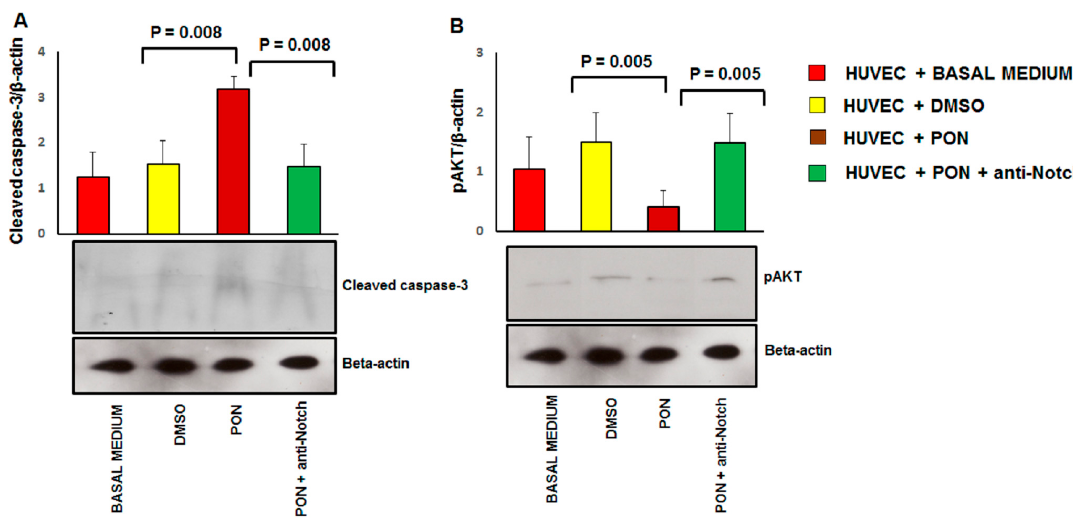
Figure 6. E ff ect of ponatinib and Notch-1 signaling inhibition on apoptosis and cell survival. Western analysis of cleaved caspase-3 (Panel ( A )) and phosphorylated AKT (Panel ( B )) expression in HUVECs treated with 1.7 nM of ponatinib or DMSO, in the presence or absence of 1 µ g / mL neutralizing factor anti-Notch-1 antibody, with β -actin serving as a loading control. The bar graph represents for each value the mean ± S.D. from 3 separate experiments. Abbreviations: Pon, ponatinib; DMSO, dimethyl